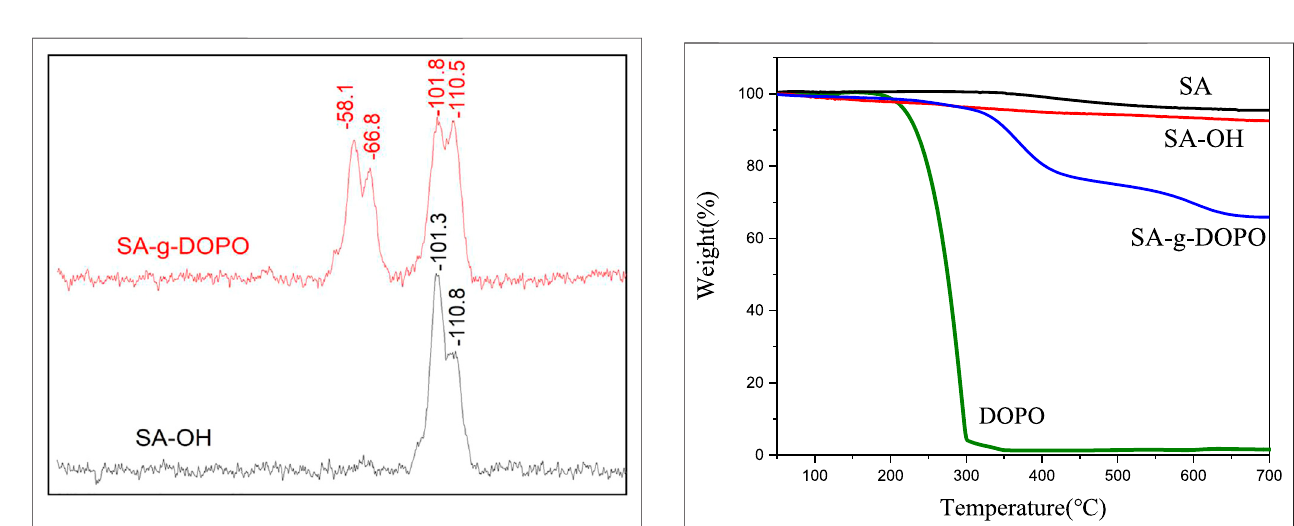
FIGURE 4 | 29 Si CP MAS-NMR spectra for SA-OH and SA-g-DOPO.